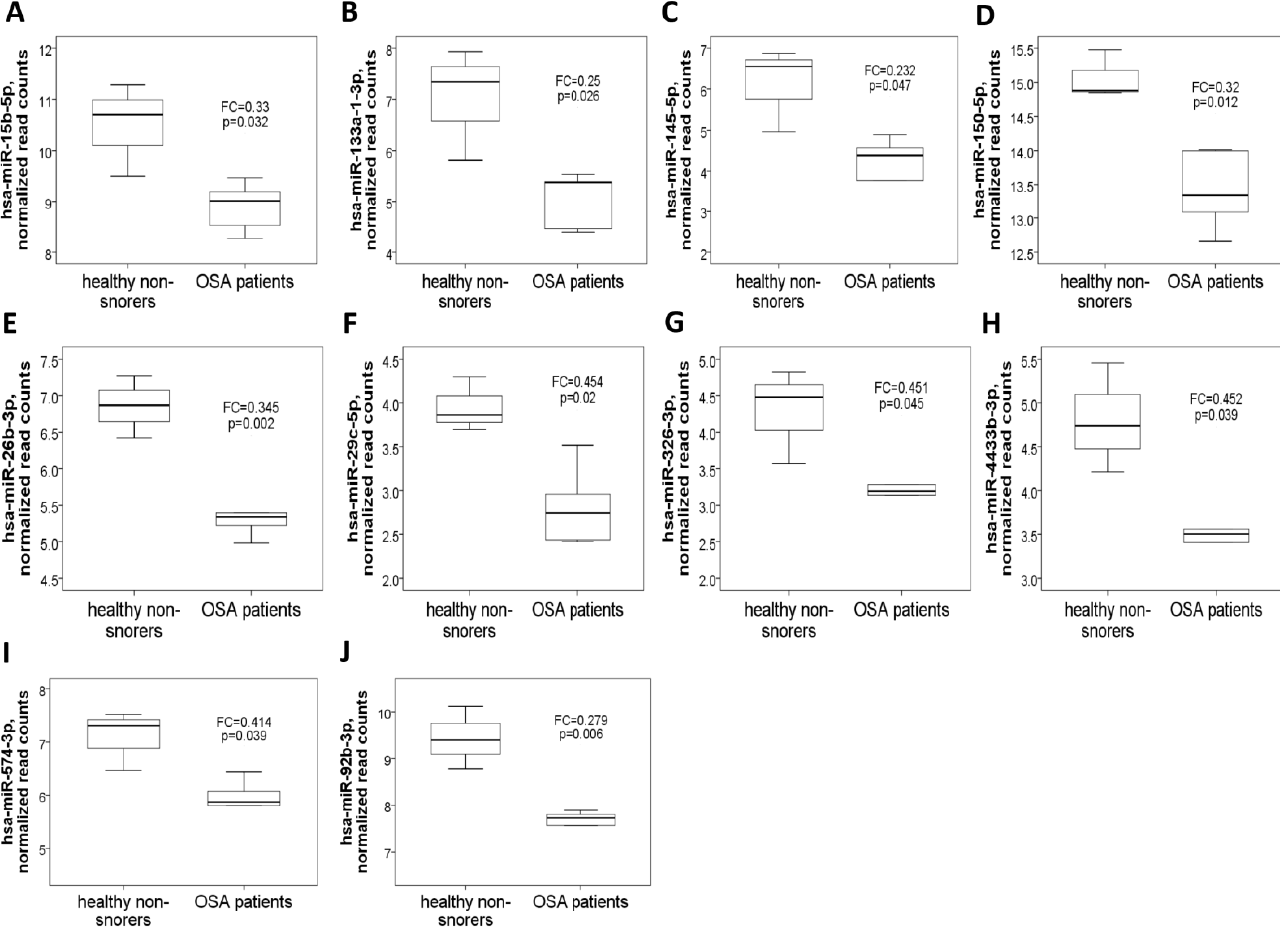
Figure 3. Ten down-regulated microRNAs identified by next-generation sequencing in the comparison between OSA patients and healthy non-snorers in the discovery cohort. Normalized read counts of the ( A ) miR-15b-5p, ( B ) miR-133a-1-3p, ( C ) miR-145-5p, ( D ) miR-150-5p, ( E ) miR-26b-3p, ( F ) miR-29c-5p, ( G ) miR-326-3p, ( H ) miR-4433b-3p, ( I ) miR-574-3p, and ( J ) miR-92b-3p genes were decreased in OSA patients versus healthy non-snorers.